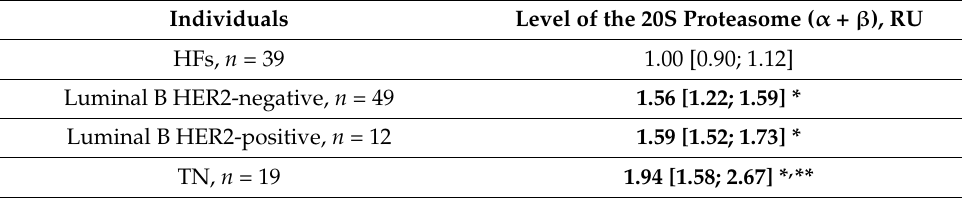
Table 4. The level of 20S proteasome in plasma exosomes from HFs and BCPs.